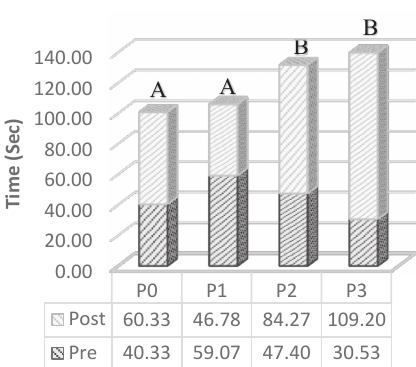
Figure 1. White tea intervention in the rats ’ swimming time (Different subset (A/B)meanstatistically difference p < 0.05)